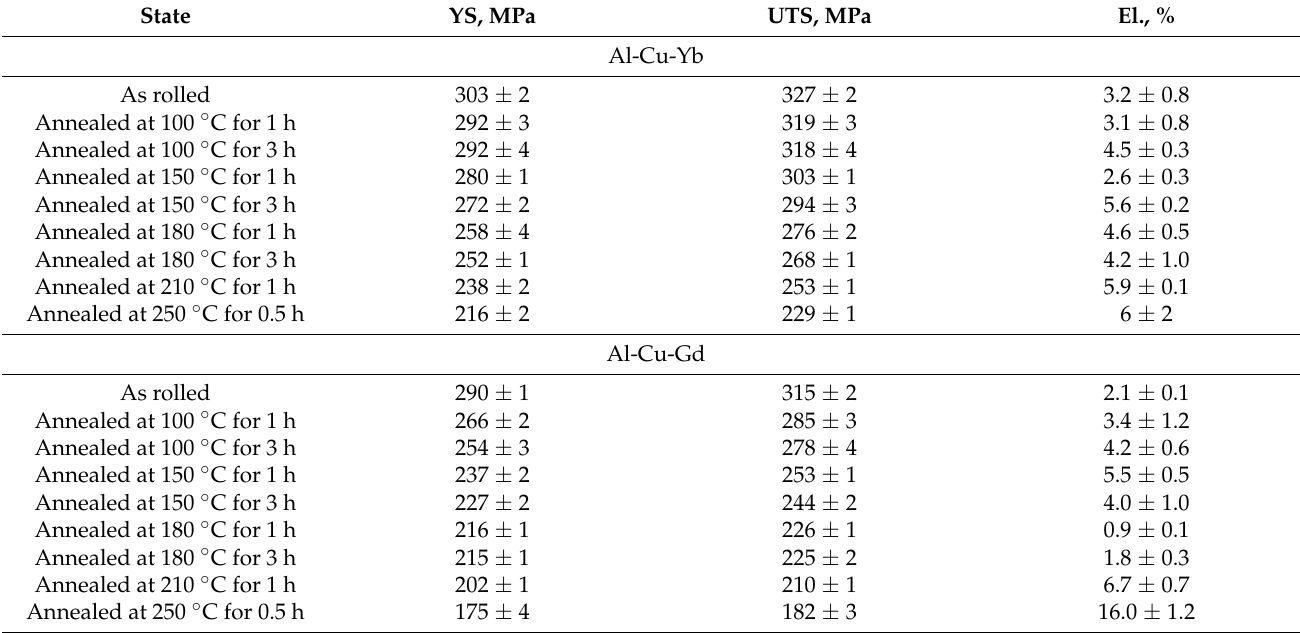
Table 2. Tensile properties of the Al-Cu-Yb and Al-Cu-Gd alloys in the as rolled and annealed states. State YS, MPa UTS, MPa El., %